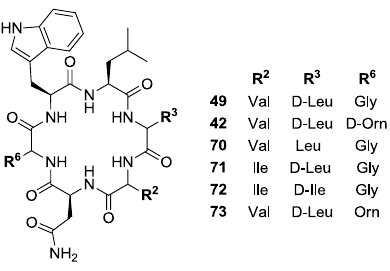
Figure 12. Structures of desotamide B ( 49 ), wollamide B ( 42 ), and cyclohexapeptide analogues 70 – 73 .